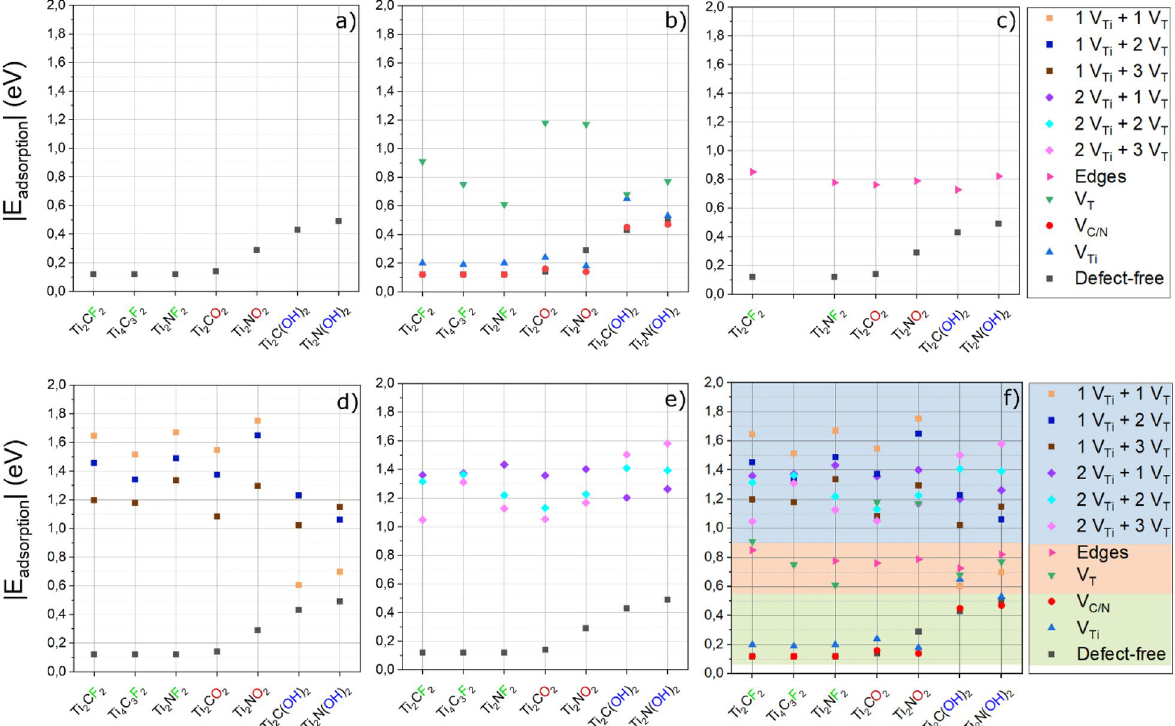
Fig. 2 Absolute values of the adsorption energy of one single water molecule on different types of MXenes: a defect-free surfaces, b surfaces with single vacancy of C/N (V C/N ), Ti (V Ti ) or termination (V T ), c edges, d , e surfaces with cluster of defects ( p V Ti termination vacancies. f Summarizes all cases considered. The highlighted intervals reflect the extent of the interaction with water: blue stands for strong chemisorption and green reflects physisorption, while red points to an intermediate